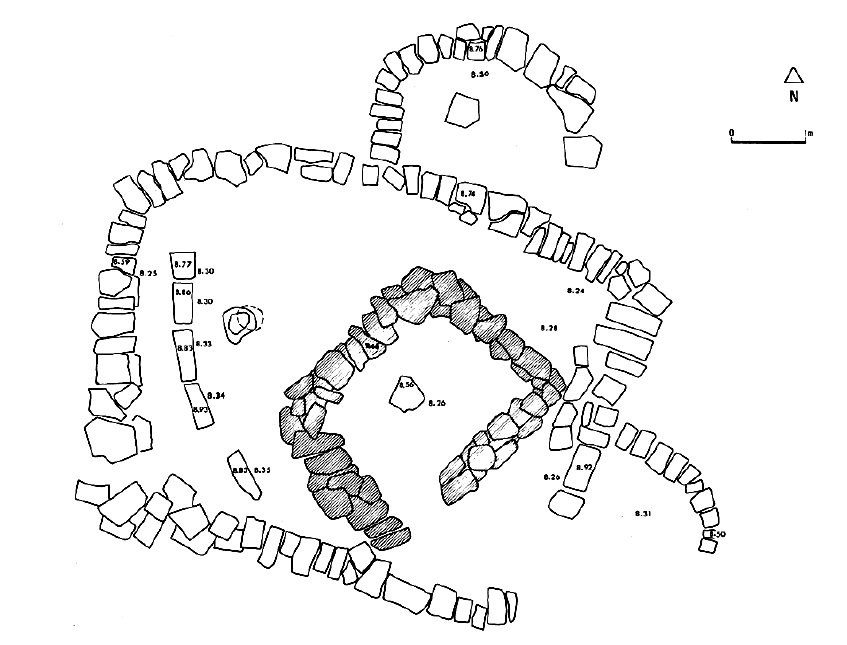
Figure 3 Consecutive open courtyard shrines at Timna Valley Site 2. Plan with the two structures: shaded stones area is the later, now dismantled, structure. After Rothenberg 1972, Fig. 33. With kind permission from Thames and